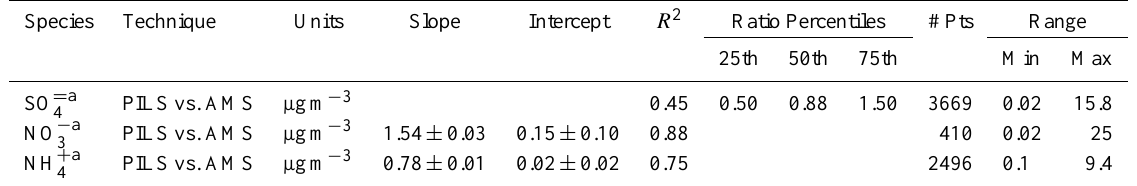
Table 5e C-130 intra-platform comparison. Particle chemical composition. NOTE: Technique is listed as X vs. Y. Species